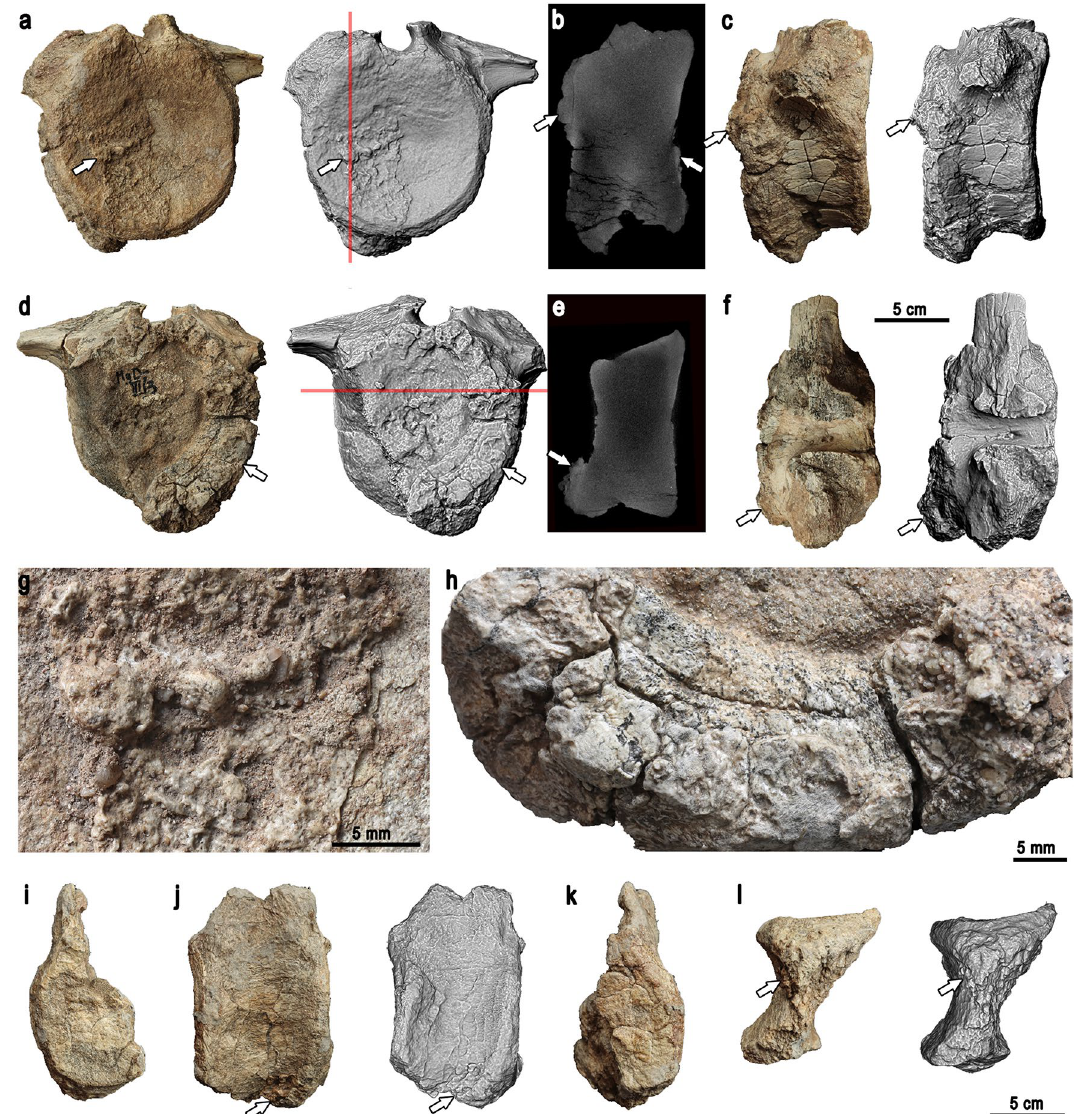
the plane of the CT section. ( e ) Coronal CT section. ( f ) Dorsal view. ( g – h ) Closeups of the calcium deposit on the cranial ( g ) and caudal ( h ) surface. ( i – l ) Middle caudal vertebra. ( i ) Cranial view. ( j ) Right lateral view. ( k ) Caudal view. ( l ) Ventral view. White arrows indicate calcium